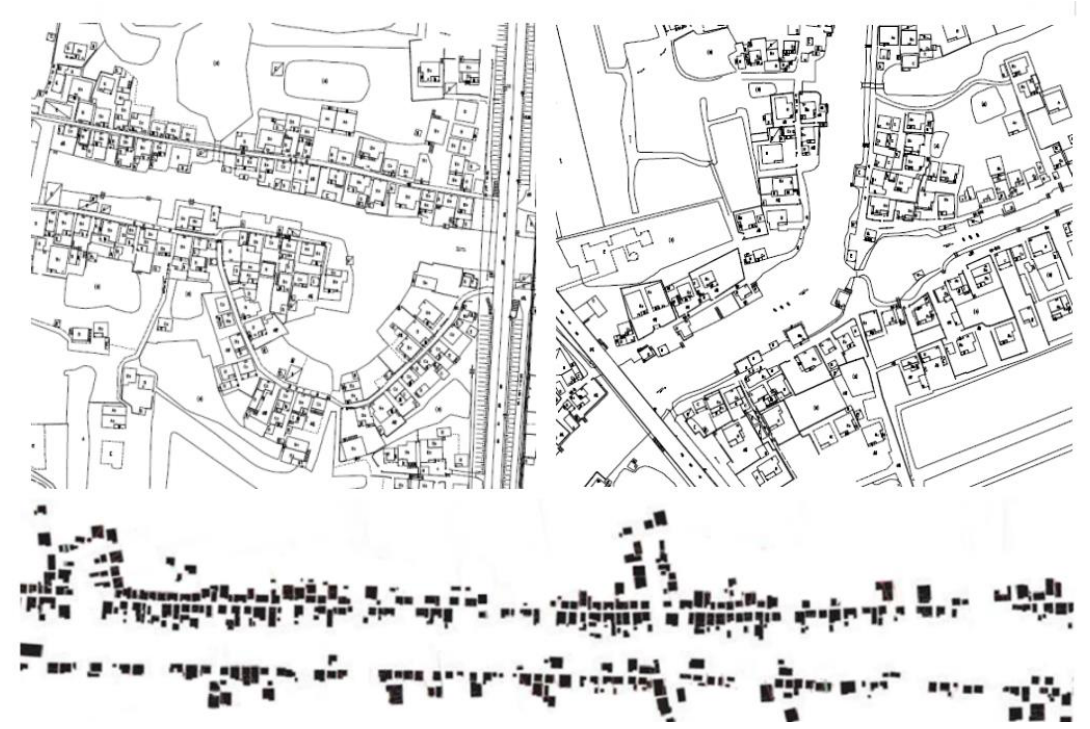
Figure 5. The fabric of Danjia Village (source: the authors).